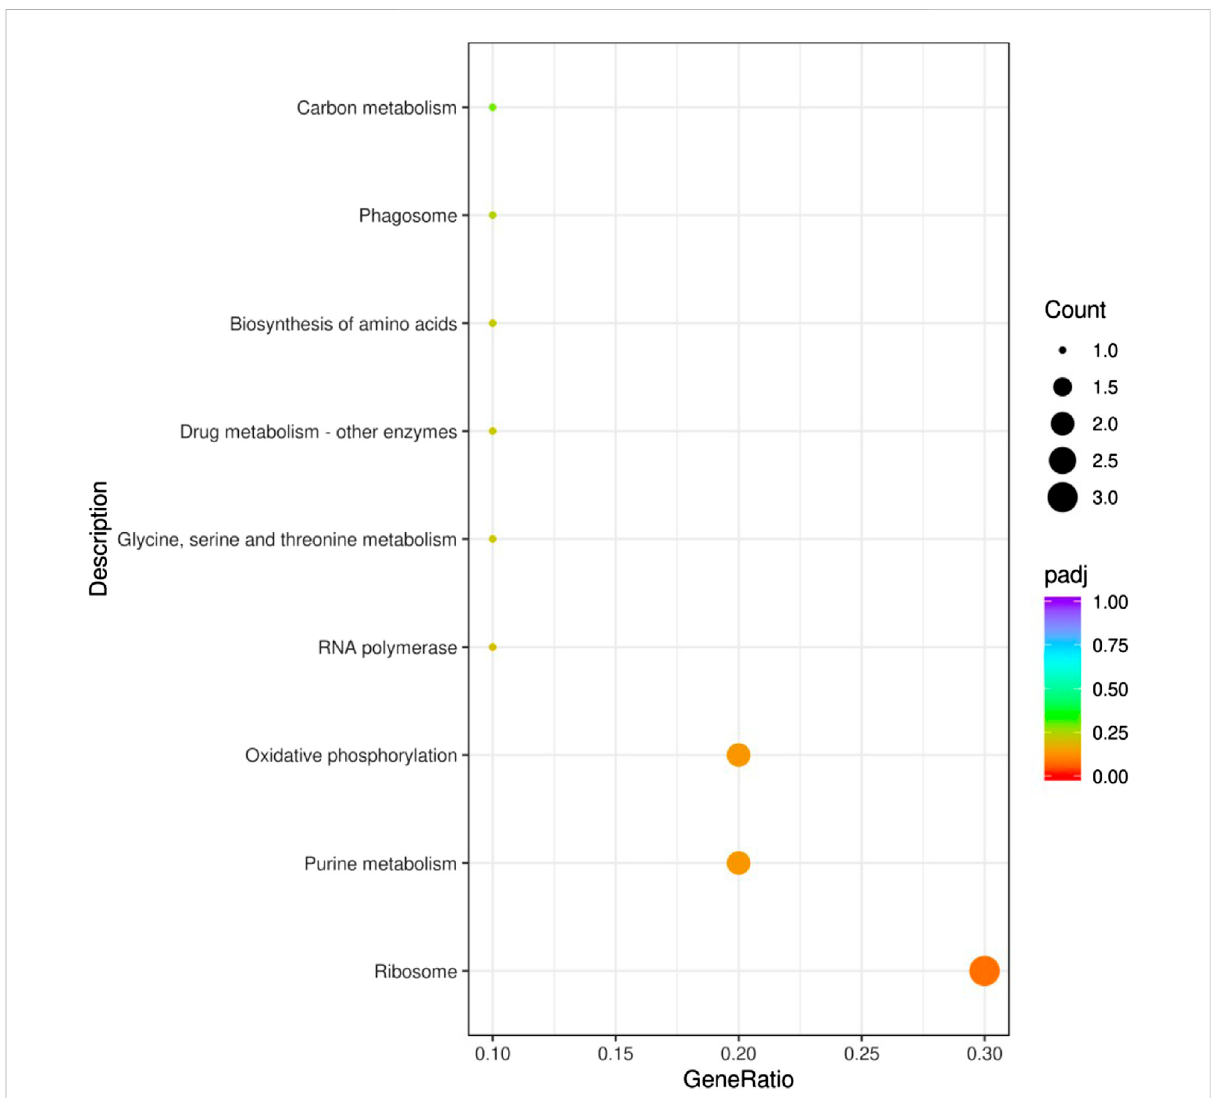
KEGG pathway enrichment analysis of DEGs. The abscissa in the fi gure is the ratio of the number of differential genes annotated to the KEGG pathwaytothetotalnumberofdifferentialgenes.TheordinateistheKEGGpathway.Count:NumberofDEGsannotatedtotheKEGGpathway.Padj: p -value corrected for multiple hypothesis